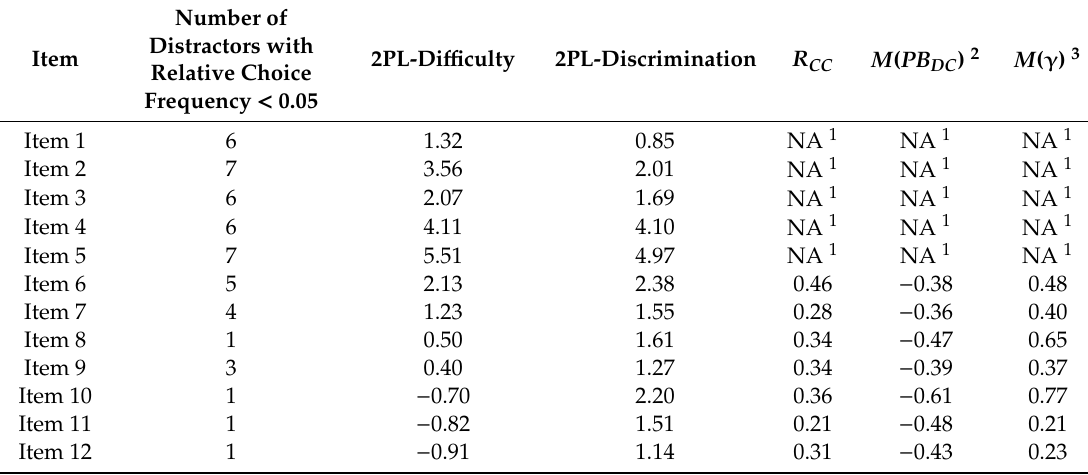
Table 4. Distractor choice frequency, 2PL-parameter estimates, and distractor e ff ect size measure findings on the Myszkowski-Storme